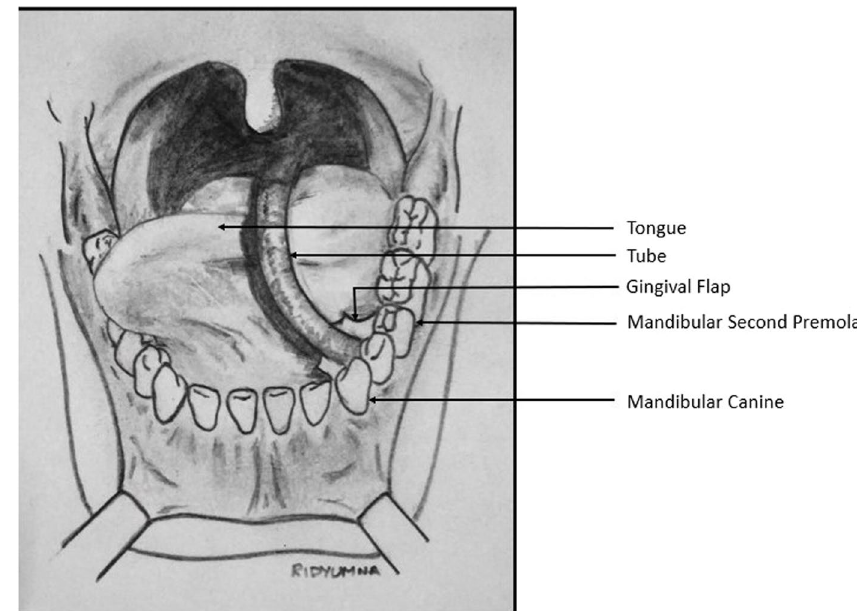
Fig. 5 Sketch demonstrating intra-oral transcrevicular incision and passage of endotracheal tube through the